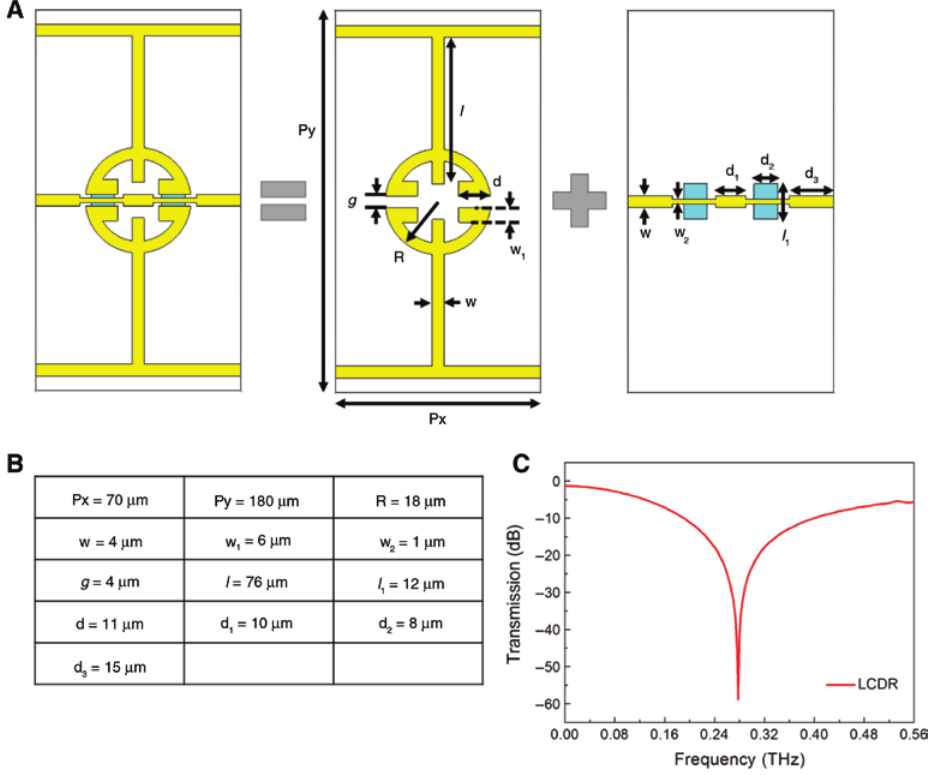
Appendix-Figure 4: Simulation detail of LCDR: (A) 2D structure model, (B) structural parameters, and (C) transmission